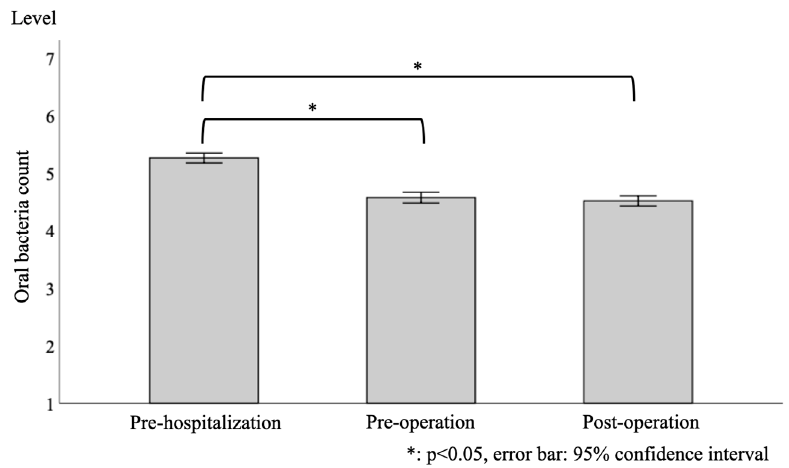
Figure 3. Longitudinal changes in the level of the oral bacterial count (at pre-hospitalization, pre- operation, and post-operation). The one-way ANOVA test showed significant differences.